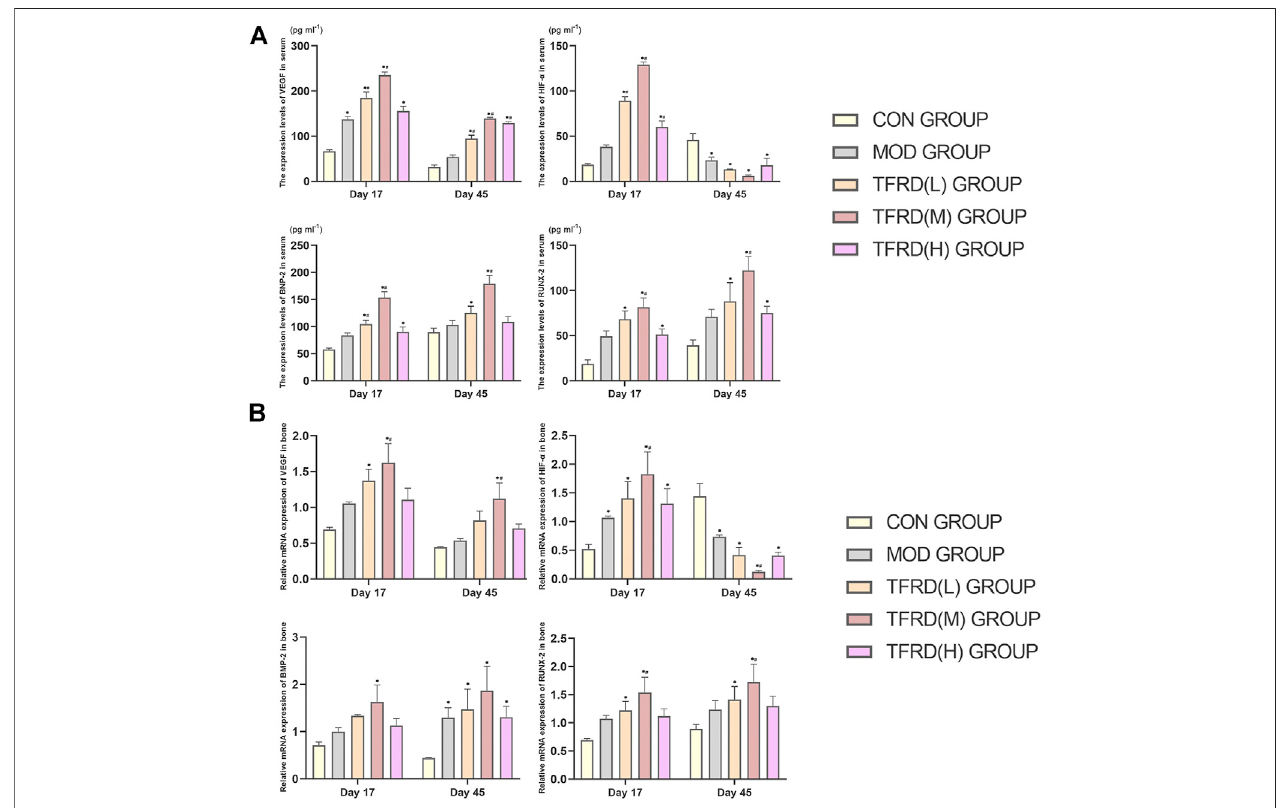
FIGURE 4 | The expression levels of VEGF, HIF-1 α , RUNX-2, and BMP-2 in serum and in bone respectively (A) . VEGF, HIF-1 α , RUNX-2, and BMP-2 concentrations in serum of DO groups detected by ELISA ( n (cid:1) 3 per group); (B) . VEGF, HIF-1 α , RUNX-2, and BMP-2 relative mRNA expression of DO groups detected by Real-Time PCR ( n (cid:1) 3 per group). The data are expressed as the mean ± SEM of three independent experiments. * p < 0.05, compared with the control group; # p < 0.05, compared with the model group.